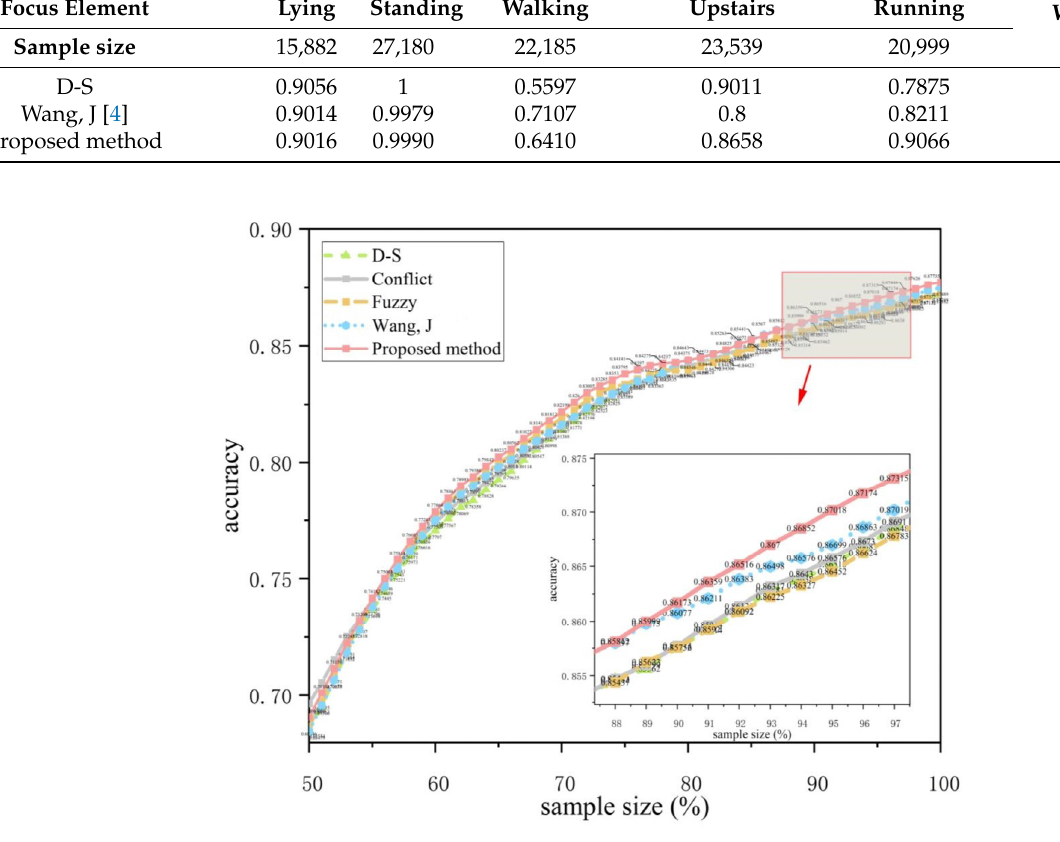
Figure 3. Accuracy of different methods with two sensors [4].